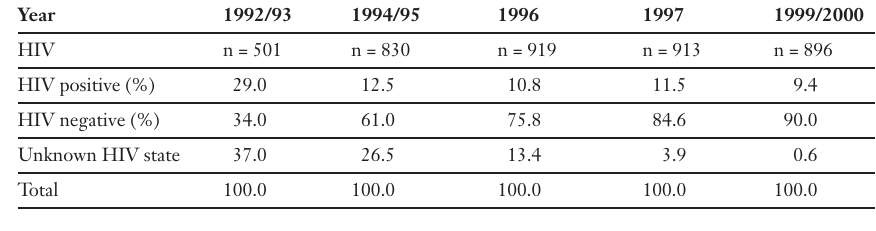
Hepatitis A, B, and C seroprevalence in patients in